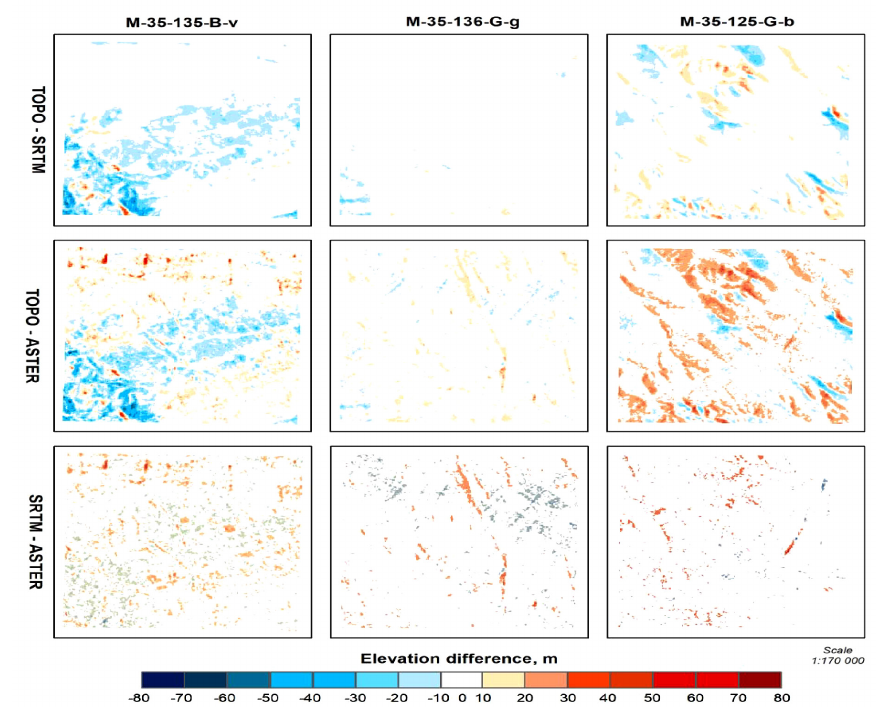
Fig. 4. The rasters of surface’s difference according to different sources of DTM